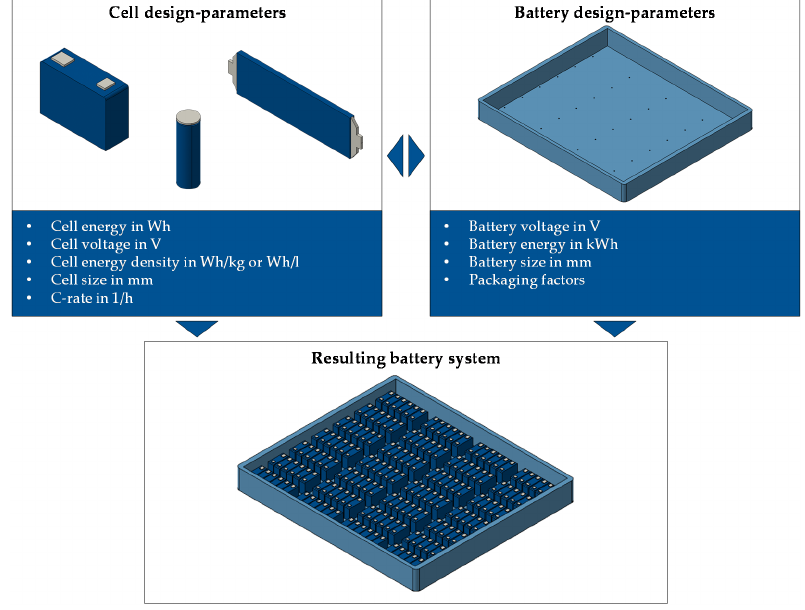
Figure 5. Overview of the design parameters for cell and battery.